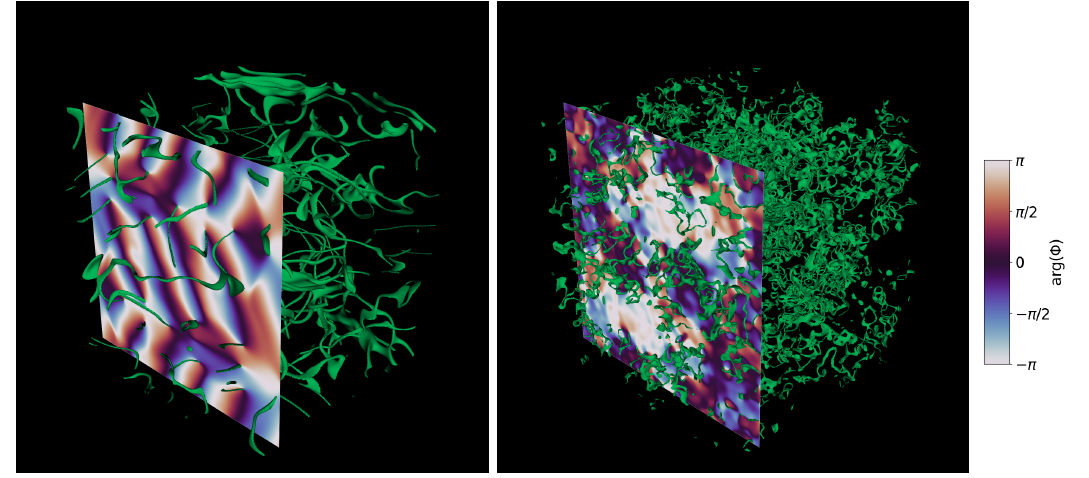
Figure 10 . Scalar field from a fully 3D dimensional case with λ/g 2 = 25 . Contours of | Φ | = v/ 10 D are indicated in green, while the complex phase of Φ is indicated on a representative two dimensional slice. The left panel shows a snapshot ≈ 3 m A 0 after vortices first form. The right panel shows a snapshot at a time ≈ 48 m A 0 after the first, illustrating how reconnections have lead to a larger number of smaller scale loops. The length of the domain is the wavelength of the dominant mode of the axion instability, which is approximately equal to the Compton wavelength of the dark photon ( L = 2 π/k p where k p ≈ 1 . 055 m A 0